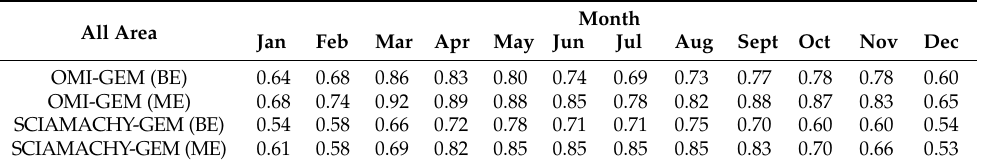
Table 6. Correlation coefficients between NO 2 tropospheric column from satellite data and GEM-AQ base emission (BE) and modified emission (ME) scenarios for 2011 over the entire modelled domain.